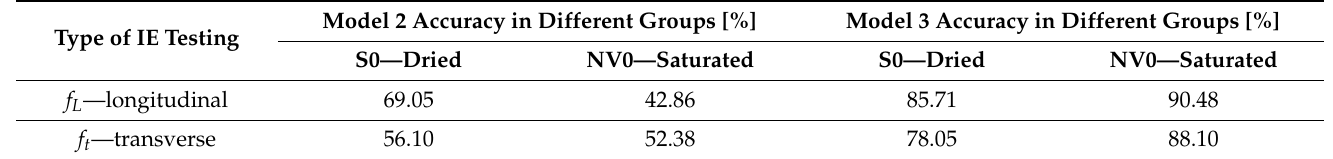
Table 2. Accuracy of model 3 in all combinations of dried or saturated specimens and testing by longitudinal or transverse